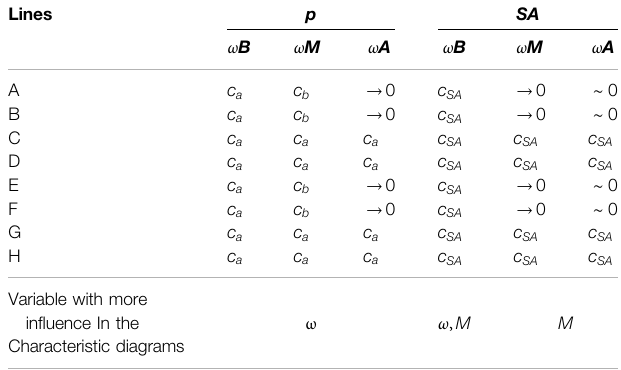
TABLE 5 | Characteristic points in the FV diagram.